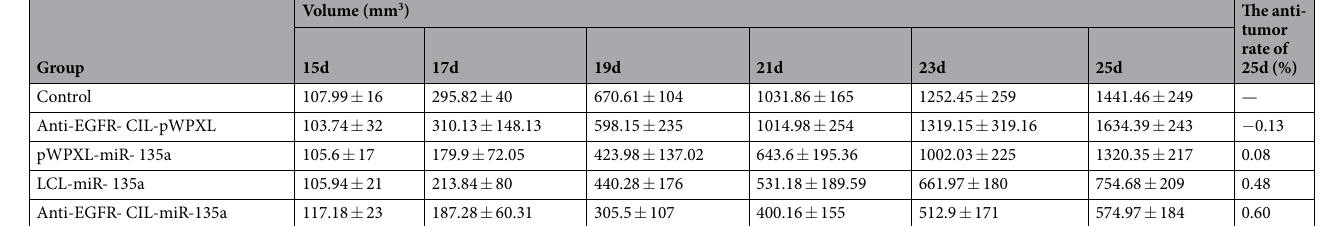
Table 3. The volume of tumor and anti- tumor rate. Tumour volumes in mice bearing GBC xenografts on days 15, 17, 19, 21, 23, and 25 after inoculation and anti-tumour rates on day 25 after inoculation. Data are expressed as the mean ± SD (n =